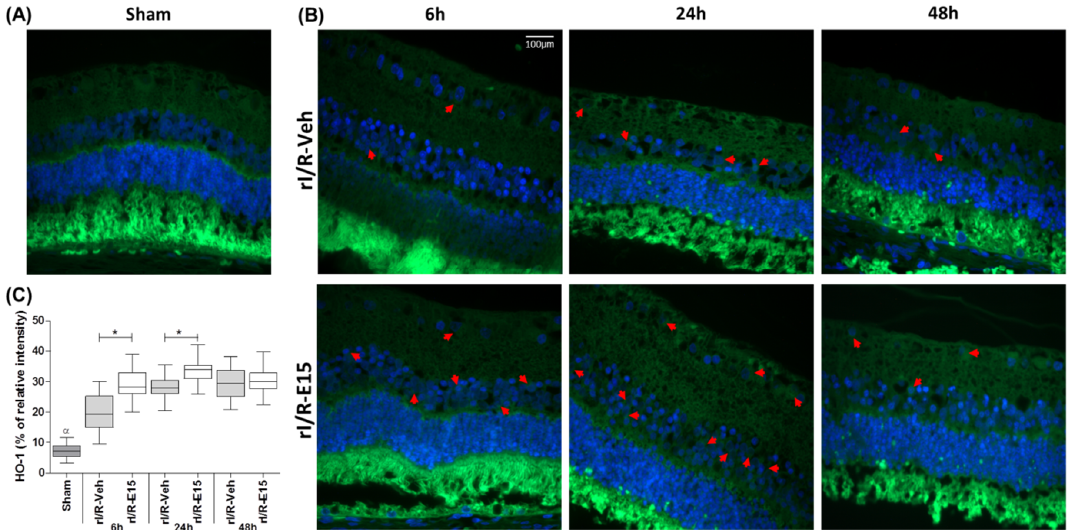
Figure 6. The antioxidant effect of E15 is related to heme oxygenase-1 (HO-1). The antioxidant effect was determined by immunostaining of HO-1 after rI/R in the timeline. ( A ) Sham group at 48 h; ( B ) rI/R-veh at 6, 24, and 48 h after rI/R (upper panel), and rI/R-E15 at the same times (bottom panel). Red arrows indicate its cytoplasmic distribution and their nuclei stained with DAPI (blue). In ( C ), shows a Box-and-whisker plot of (median, first-third quartile, minimum- maximum value) with the percentage of HO-1 staining intensity in all groups. * p < 0.05 compared to rI/R-veh and α p < 0.01 compared to rI/R-veh and rI/R-E15 at 48 h. Scale bar = 100 μm.